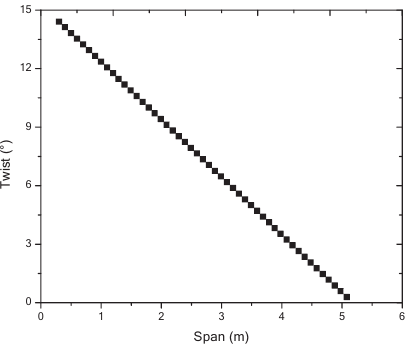
Figure 2. Assumed geometrical twist distribution